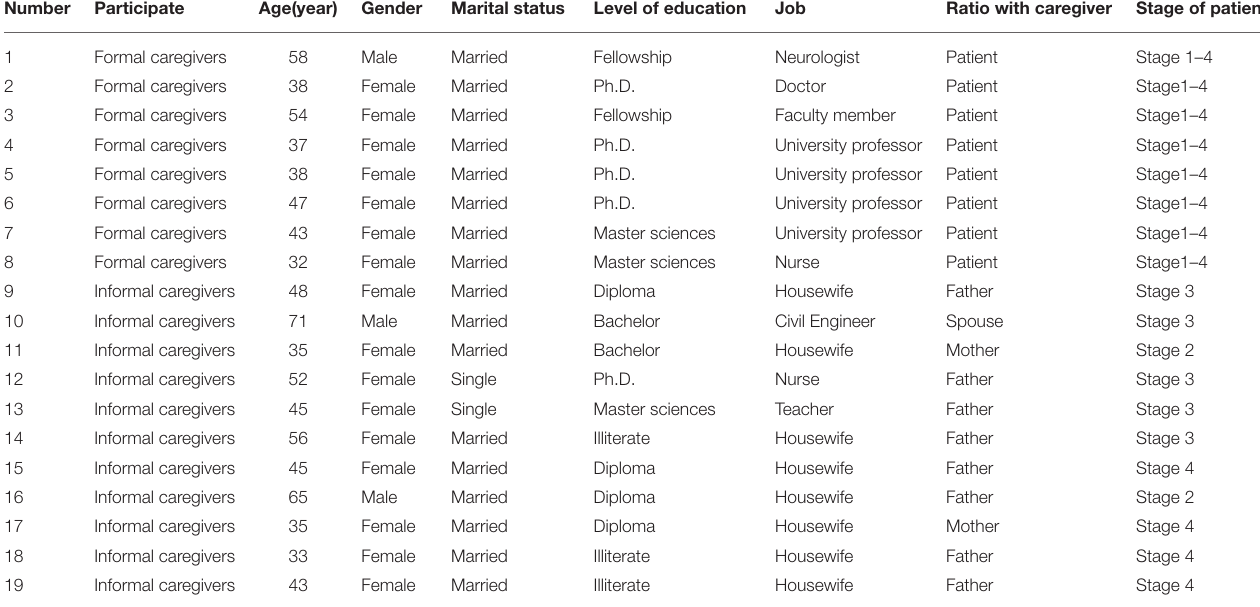
TABLE 1 | Demographic characteristics of the participants in the study. Number Participate